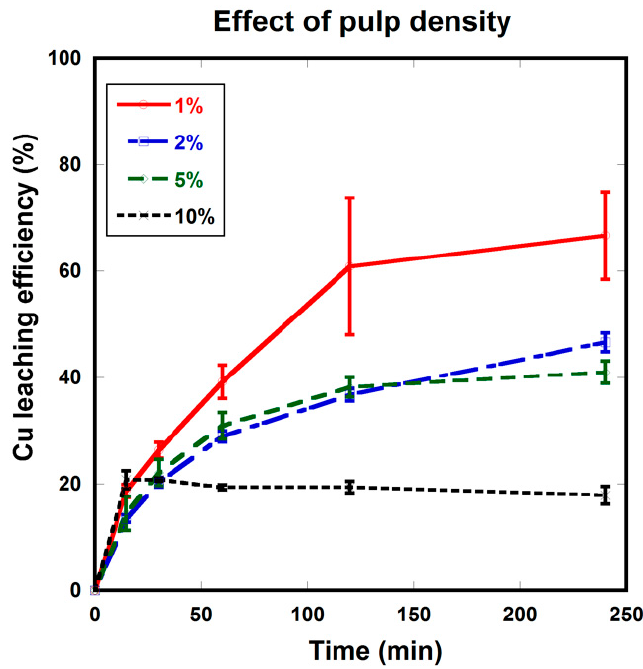
Figure 4. Effect of pulp density (Ferric sulfate—50 mM, Temperature—20 °C, and agitation—150 rpm).